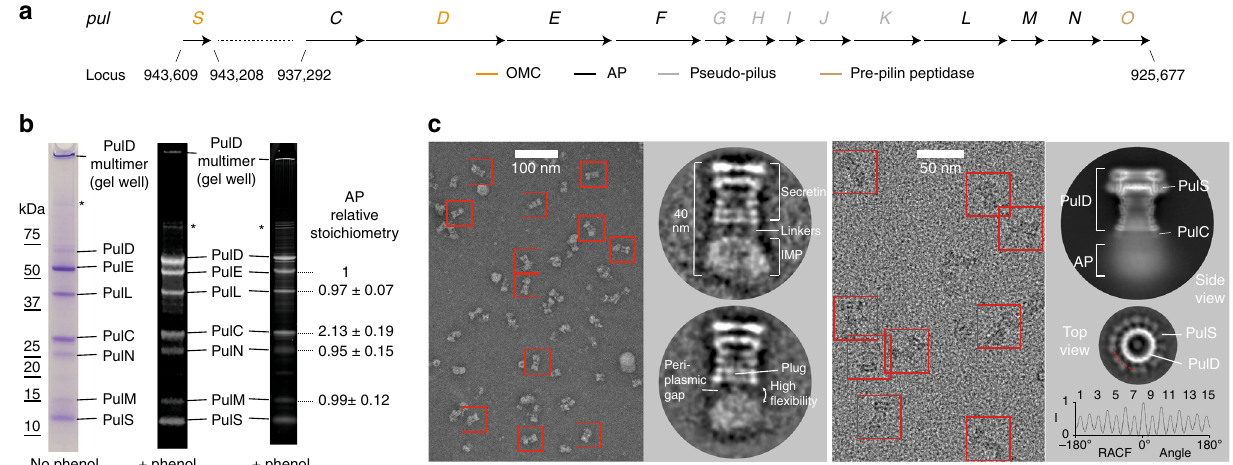
Fig. 1 Puri fi cation, stoichiometry and EM analysis of the Pul CDELMNS complex. a Schematic showing the chromosomal location and gene arrangement for the Klebsiella pneumoniae T2SS. OMC outer membrane complex, AP assembly platform. b Typical SDS-PAGE analysis of the Pul CDELMNS complex. (Left) Coomassie R250 stained gel without phenol treatment. (Middle) Fluorescent emission Coomassie R250 stained gel imaged at 680 nm with phenol extraction. Residual PulD remains in the gel well. (Right) Fluorescent emission Sypro Ruby stained gel imaged at 302 nm with phenol extraction. Relative mean stoichiometry and standard deviation for all assembly platform (AP) components are indicated. Stoichiometry measurements were determined from six independent puri fi cations. Asterisk indicates PulD multimer. Source data are provided as a Source Data fi le. c Left panel shows typical negative stain EM micrograph of the Pul CDELMNS complex with selected individual particles highlighted with a red box. Zoomed images of 2D class averages are also shown. Right panel shows typical cryo-EM micrograph of the Pul CDELMNS complex with associated side view 2D class average. Top view 2D class average shows PulS and PulD with C15 symmetry based on the RACF. Red dotted line indicates radial ring for RACF